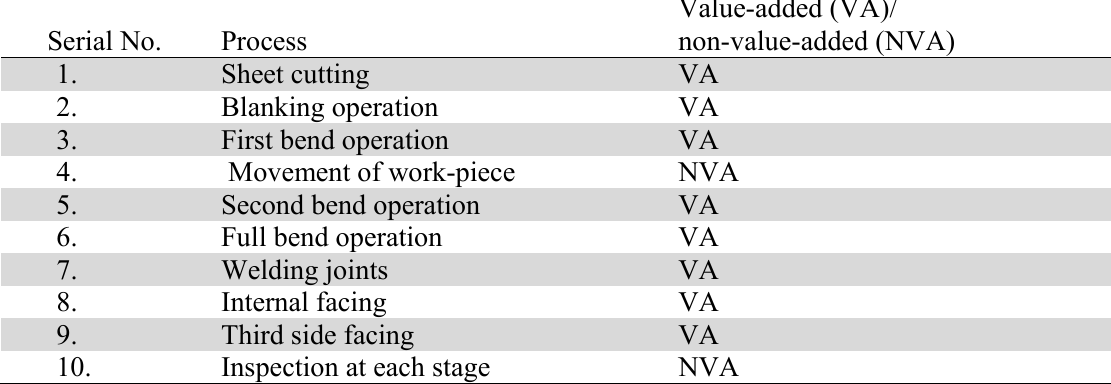
Value-added and non-value-added activities Serial No.